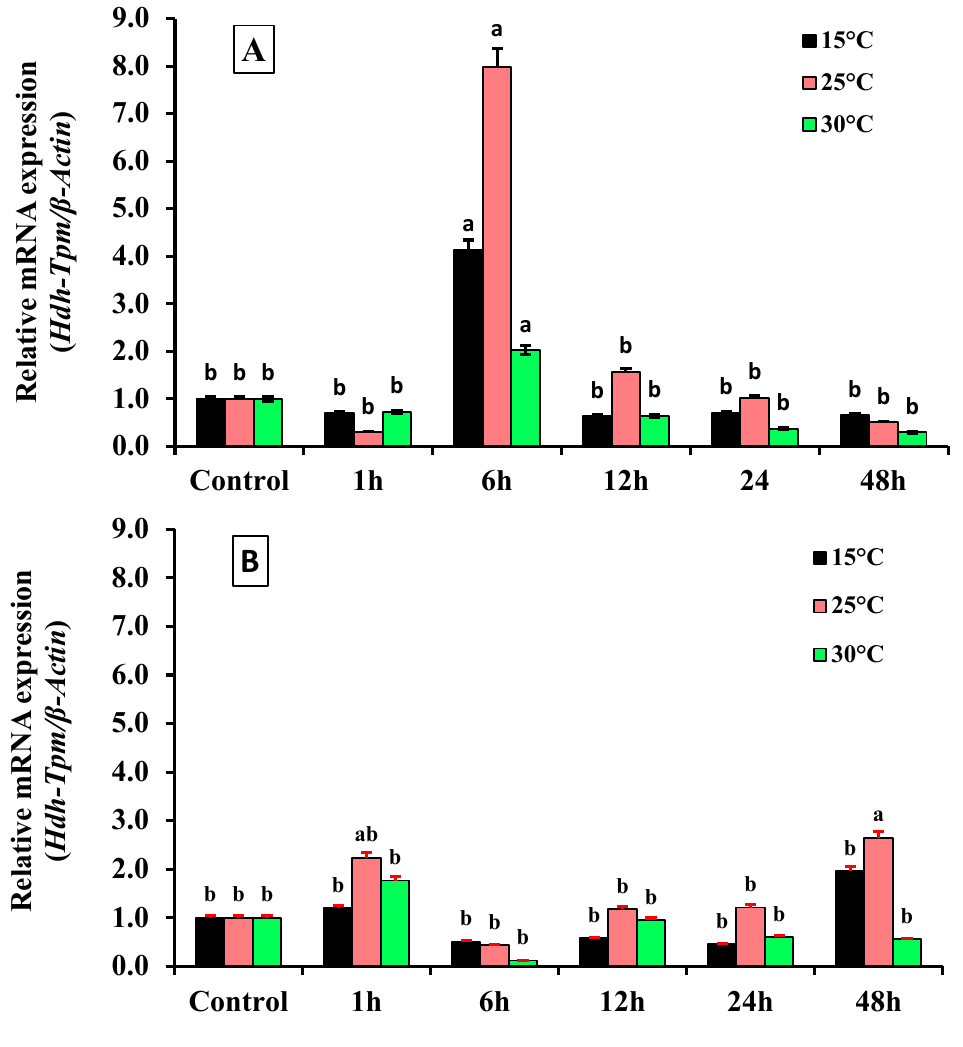
Figure 10. Expression of Hdh-TPM mRNA at different heat stress conditions: ( A ) Muscle tissue and ( B ) mantle tissue of Pacific abalone. Significantly different levels ( p < 0.05) are denoted by different letters.